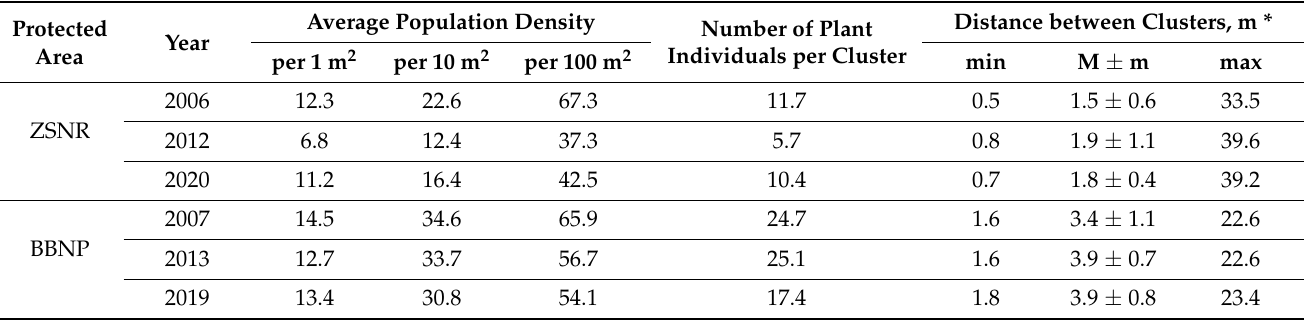
Table 2. Spatial distribution of individual P. chlorantha at the southern range margin (ZSNR—the Zhiguli State Nature Reserve, BBNP—the Busuluksky Bor National